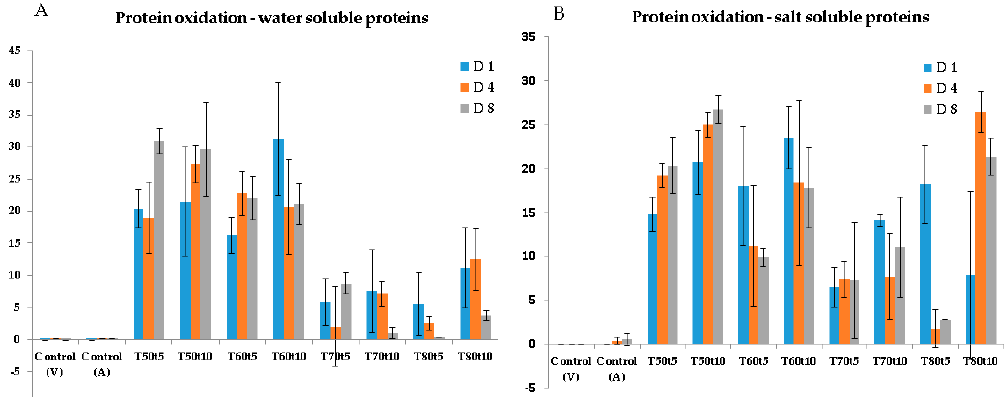
Figure 2. Total carbonyls in sarcoplasmic ( A ) and myofibrillar proteins ( B ), obtained on the cod samples as a function of cooking temperature; T, cooking time; t, and storage days; D (V; vacuum-packed samples, A; air-packed